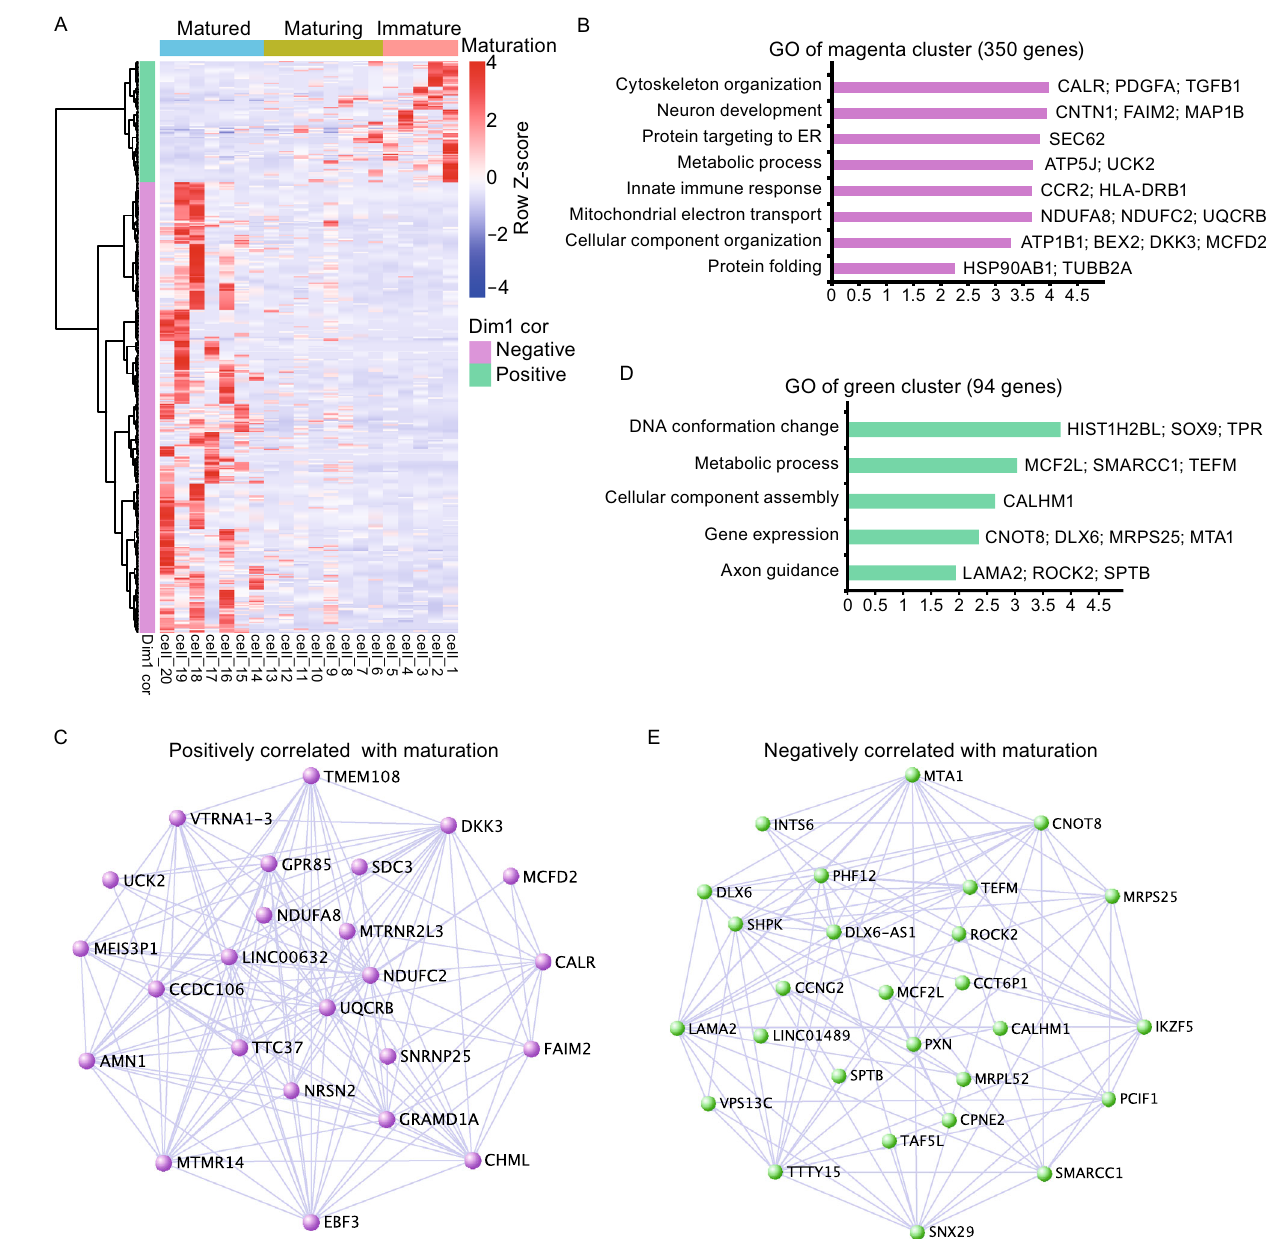
Figure 4. Single cell transcriptome analysis revealed maturation-related genes. (A) Expression of genes positively (green cluster) and negatively (magenta cluster) correlated to dimension 1 of electrophysiological parameters (Correlation > 0.4 and P < 0.05, Student correlation P -values) in 20 single neurons. (B) GO analyses of genes negatively correlated to dimension 1 (magenta cluster, 350 genes), enriched in mature neurons. Length of bars indicated the signi fi cance ( − log10 transferred P -value, Fisher exact test). (C) Hub-gene network of the magenta gene cluster. (D) GO analyses of genes positively correlated with dimension 1 (green cluster, 94 genes), enriched in immature neurons. Length of bars indicated the signi fi cance ( − log10 transferred P -value, Fisher exact test). (E) Hub-gene network of the green gene